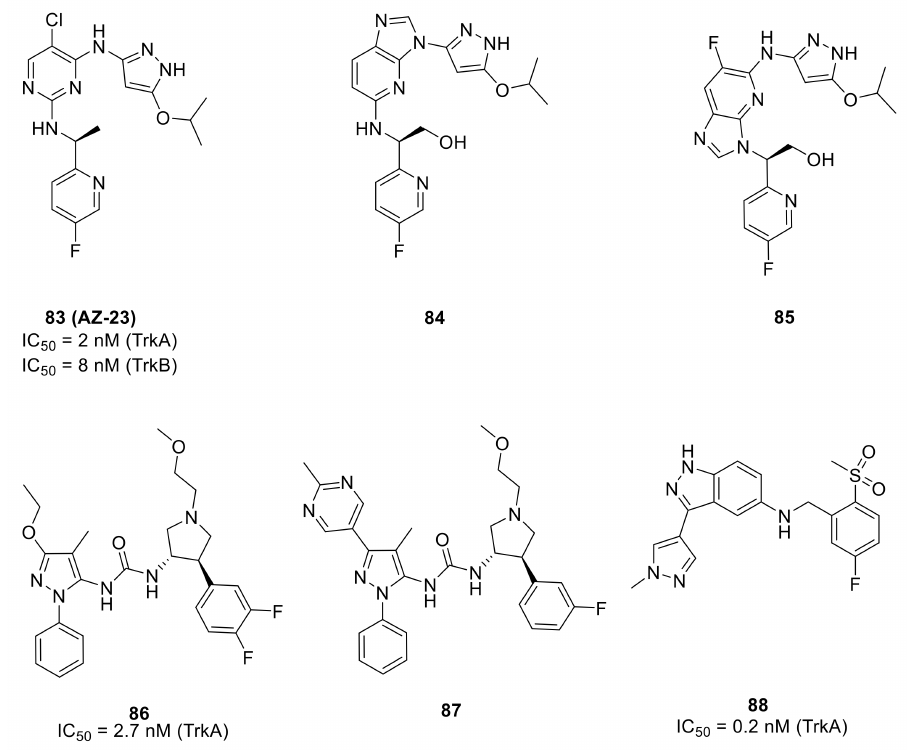
Figure 92. Structures of pyrazole-based TRK inhibitors and their IC 50 values.